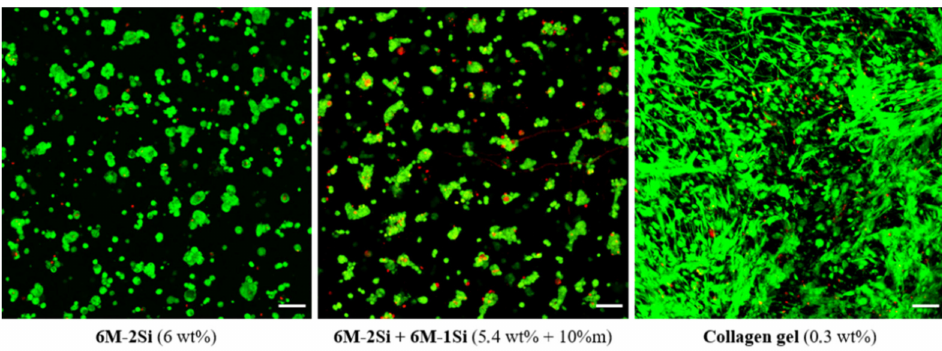
Figure 7. Cell viability of hMSCs measured by LIVE/DEAD staining in different hydrogels after one day of encapsulation. Images are the maximum intensity z-projection. Scale bar is 100 µ m.